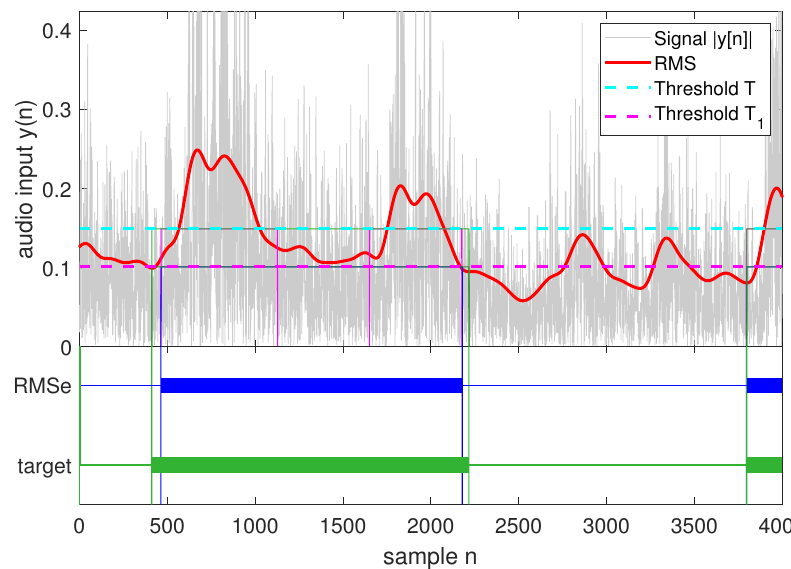
Figure 8. RMSe detectors applied on sequences of impulses.